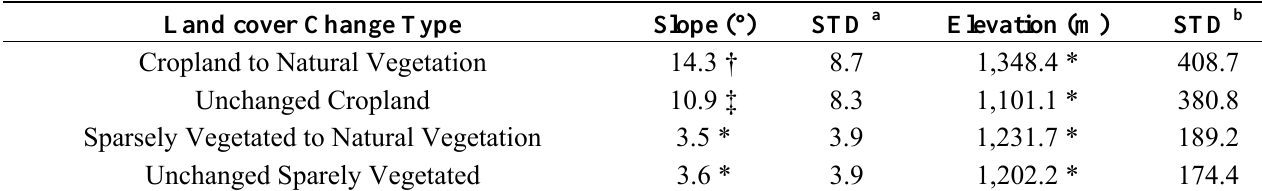
Table 5. Slope and elevation